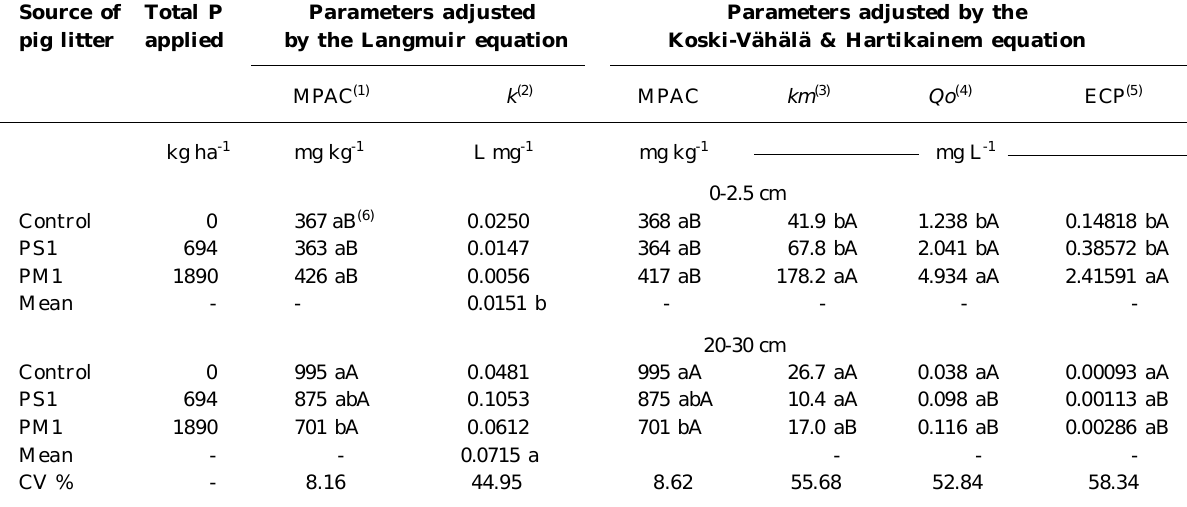
Table 2. Parameters related to the adsorption isotherms in the 0-2.5 and 20-30 cm layers of a Typic